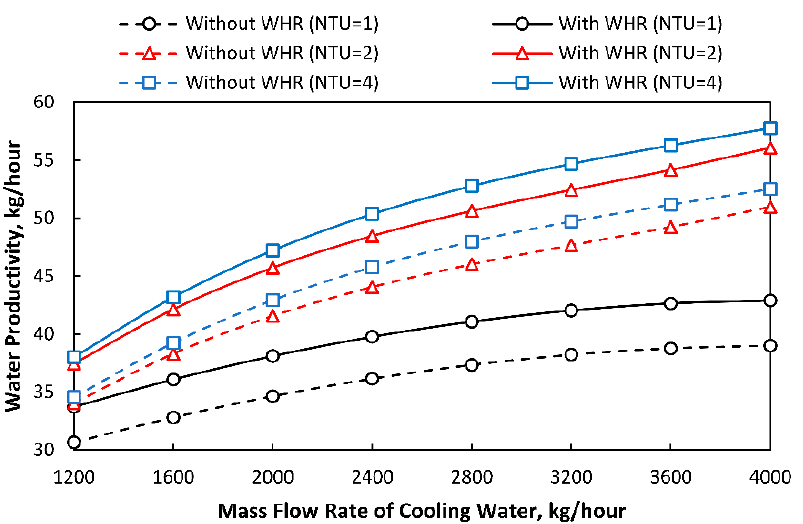
Figure 9. Effect of MFR of cooling water on freshwater productivity with and without waste heat recovery.